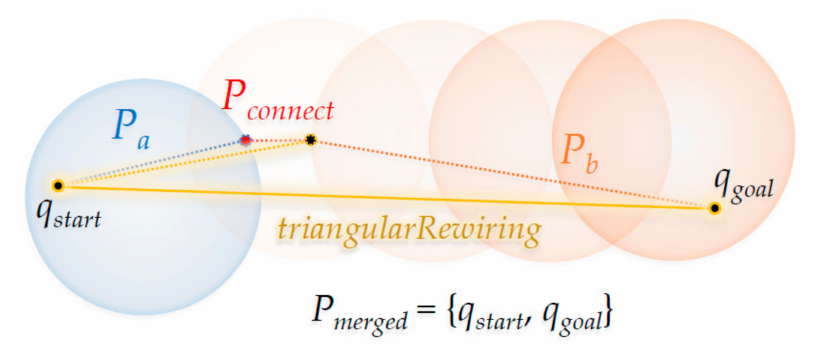
Figure 8. Proposed ‘Connect’ method for the RRT-Connect